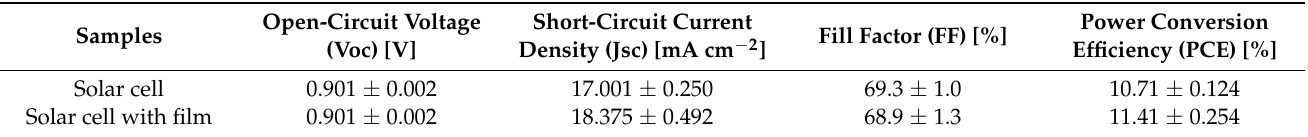
Table 2. Photovoltaic parameters of the PBDB-T:ITIC-based conventional solar cells and solar cells with tunicate cellulose composite